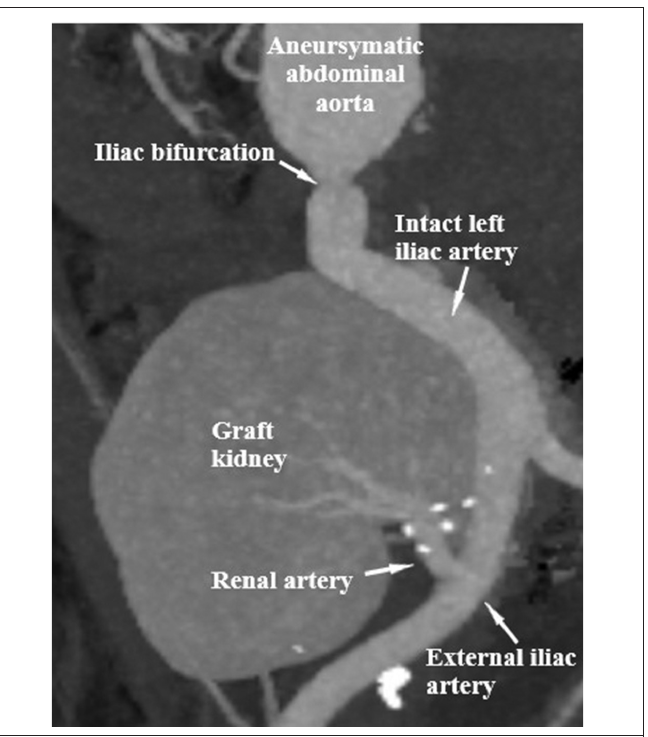
Figure 3. Postoperative computerized tomographic angiography; aneursymatic abdominal aorta, transplanted (graft) kidney, intact iliac bifurcation, intact left iliac artery, external iliac artery, and renal